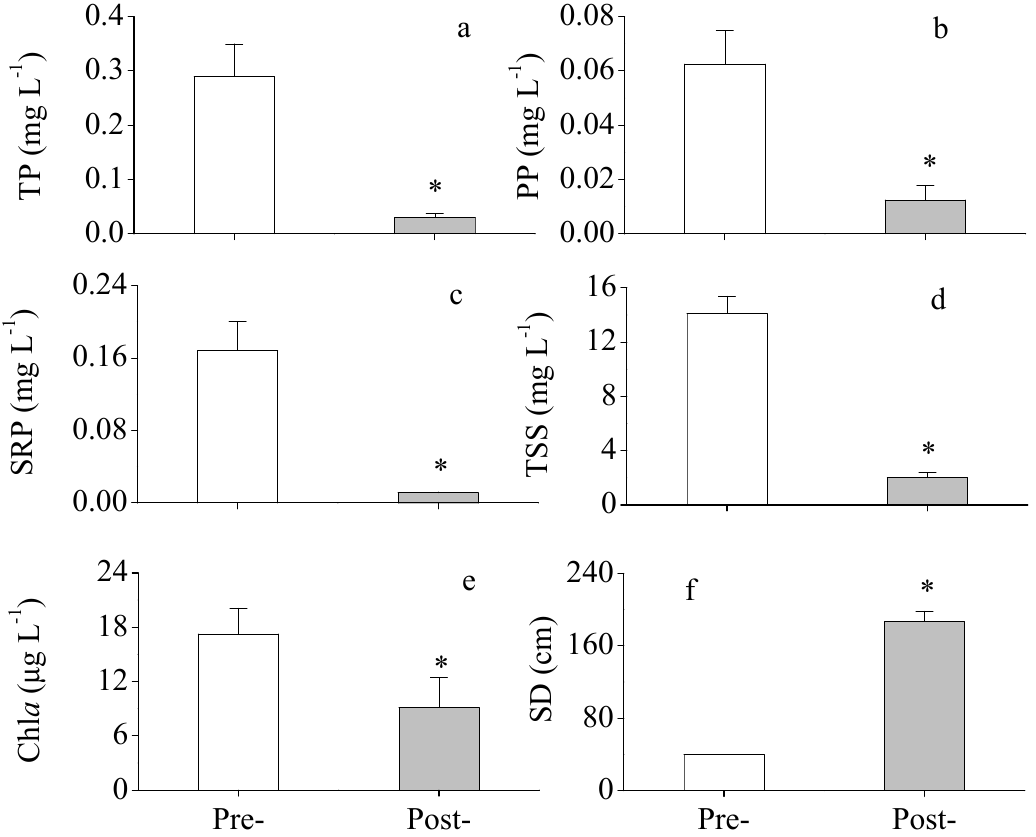
Figure 2. Changes in the concentrations of total phosphorus (TP) ( a ), particulate phosphorus (PP) ( b ), soluble reactive phosphorus (SRP) ( c ), total suspended solids (TSS) ( d ) and chlorophyll a (Chl a ) ( e ) in the water, and Secchi depth (SD) ( f ), in the experimental area of Lake Yanglan in pre- to post- application of PAC and Phoslock ® periods ( n = 3). * represents the significant difference ( p < 0.05) between treatments using Student’s t -test. Table 1. Results of the Student’s t -test for the concentrations of total phosphorus (TP),